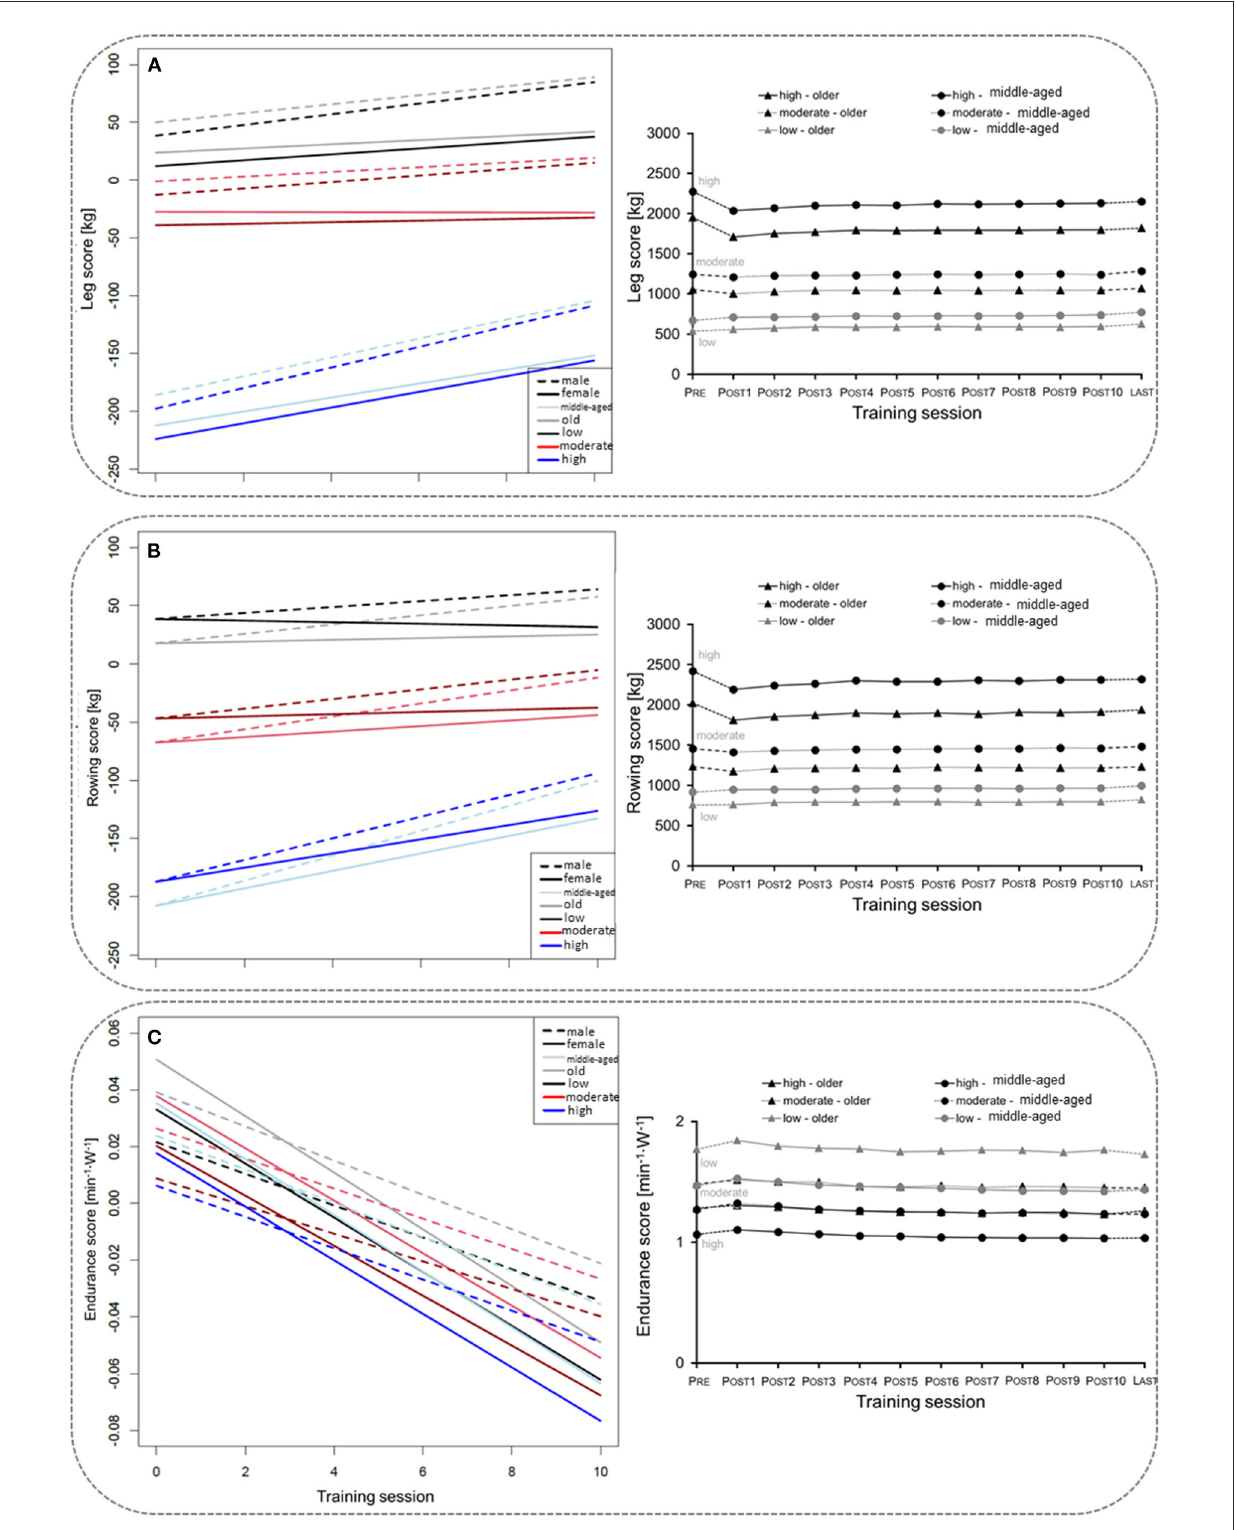
FIGURE1 Left column: Course of changes in the for the leg score (A) , rowing score (B) , and endurance score (C) over the first ten training sessions after the lockdown. Negative values indicate losses in the leg and rowing score in comparison to the values before the lockdown, and lower heart rates per given work rate. Right column: Description of the mean for the leg score (A) , rowing score (B) , and endurance score (C) before (Pre), during the ten first sessions after the lockdown period 1( POST 1–10), and for the last training session ( LAST ) before the second lockdown in Germany, considering age and training intensity groups (TIG; low, moderate, high) based on the leg score before the lockdown (pre-COVID-19 legscore ). SE are too small to be